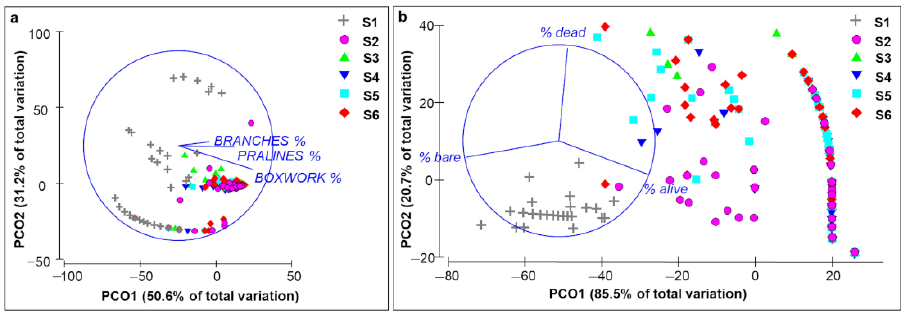
Figure 7. Principal Coordinates Analysis (PCO) ordination plot of the sampling sites related to morphotypes coverage ( a ) and dead/live ratio ( b ). Correlation vector is based on Pearson ranking.